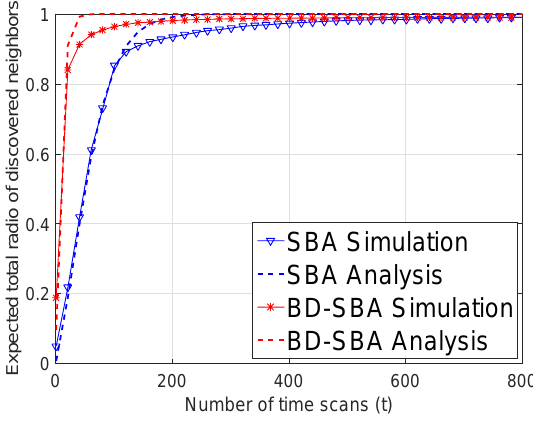
Figure 10. Validation of